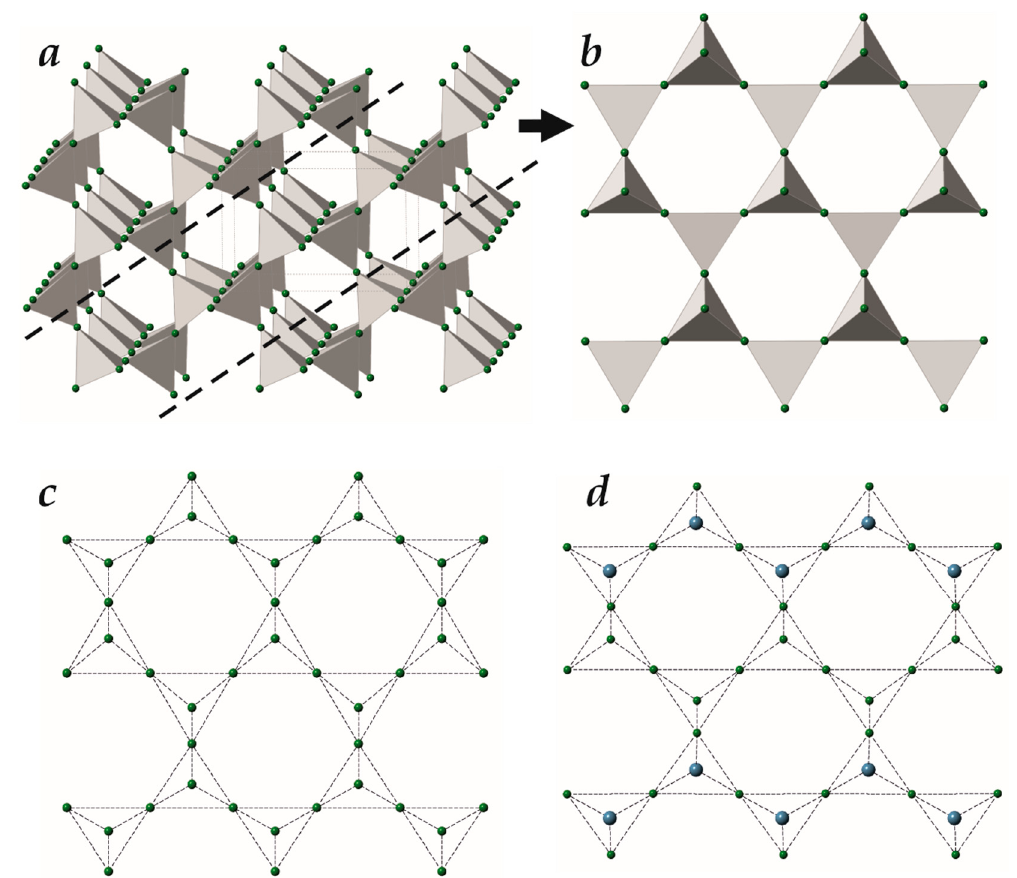
Figure 8. The array of Cu atoms shown as a cristobalite- or pyrochlore-like framework of corner-sharing Cu 4 tetrahedra ( a ); the sheet excised from the framework along the plane indicated by striated line as shown in a ( b ); the ball-and-stick representation of the 2D Cu-capped kagomé array in atacamite ( c ) and the 2D Cu-Ca array in dioskouriite polytype ( d ).